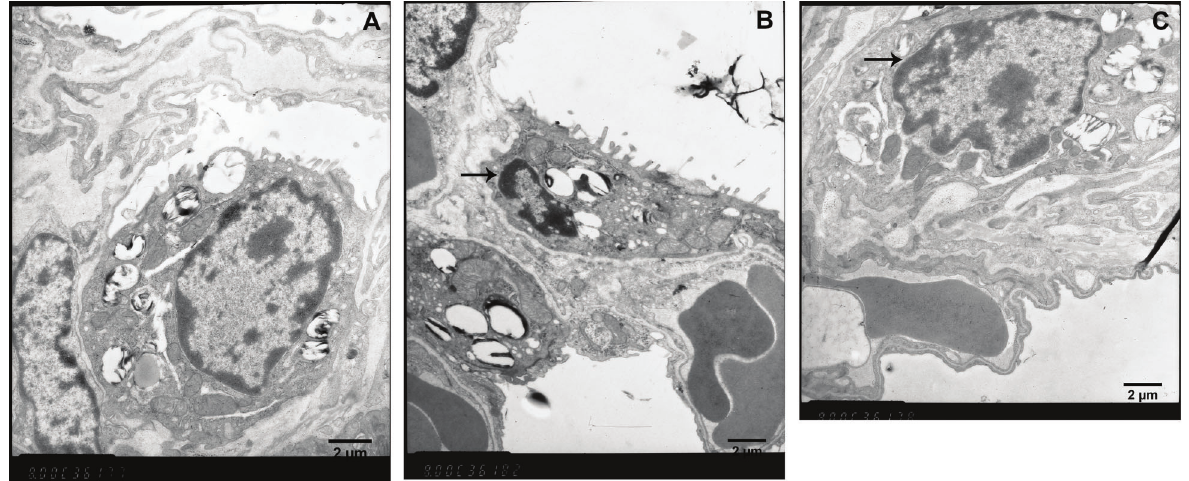
Figure 3. Transmission electron microscopy images of transverse sections of lung tissue. A , Air-blood barrier and endothelial structure had a normal appearance in the CTRL control group (saline). B , In the LPS group (5 mg/kg lipopolysaccharide), type II epithelial microvilli were absent or shortened, lamellar bodies were empty and chromatin was visible at the periphery of nuclei. C , There was no detectable apoptosis in the sevo fl urane (2.5%) group (magni fi cation, 8000 (cid:1) ).